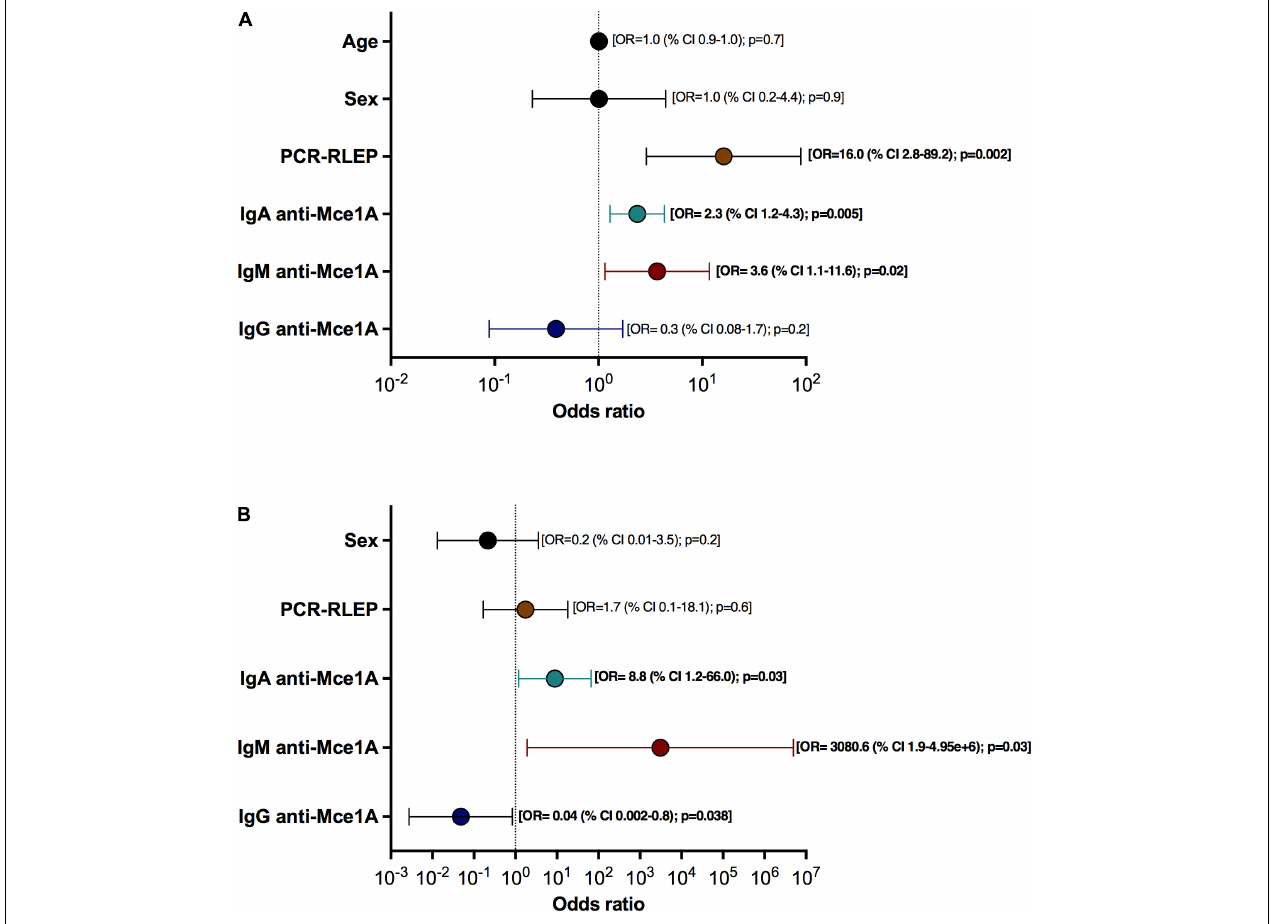
FIGURE 5 | Potential of anti-Mce1A antibodies as predictors of the diagnosis of HD. Binomial logistic regression analyses showing odds ratios (ORs) and 95% confidence intervals (CIs) for HD diagnosis with independent variables: age, sex, PCR-RLEP, and antibodies against Mce1A (IgA, IgM, and IgG) for all groups (PAR-NC, CAR-TP, HHC, and EC) (A) and between untreated patients (PAR-NC) and treated patients (CAR-TP) (B)